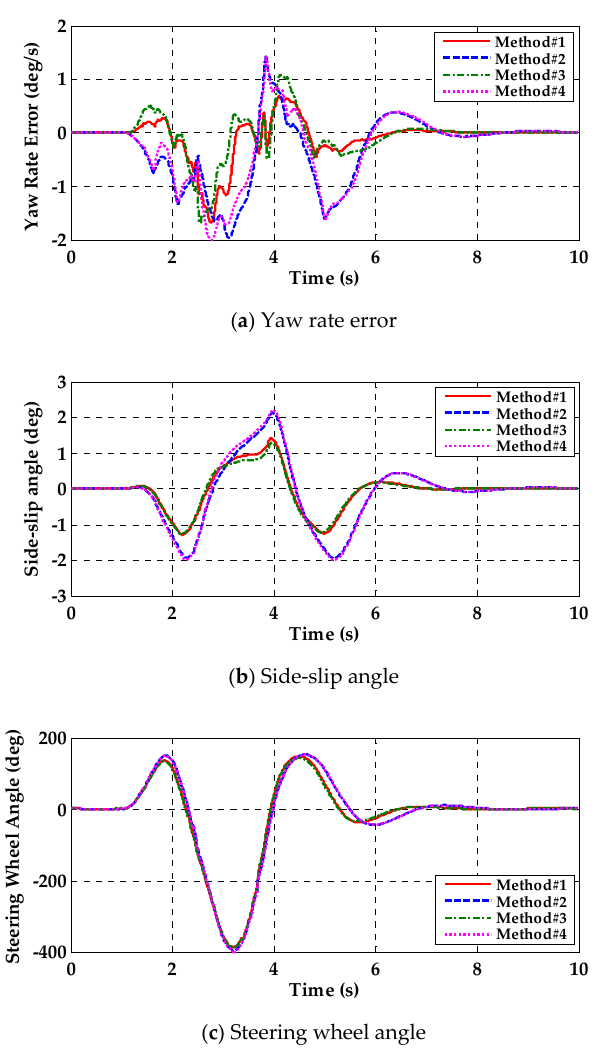
Electronics 2020 , 9 , x FOR PEER REVIEW Figure 6. Simulation results of 4WIS for each method. Figure 6. Simulation results of 4WIS for each method.